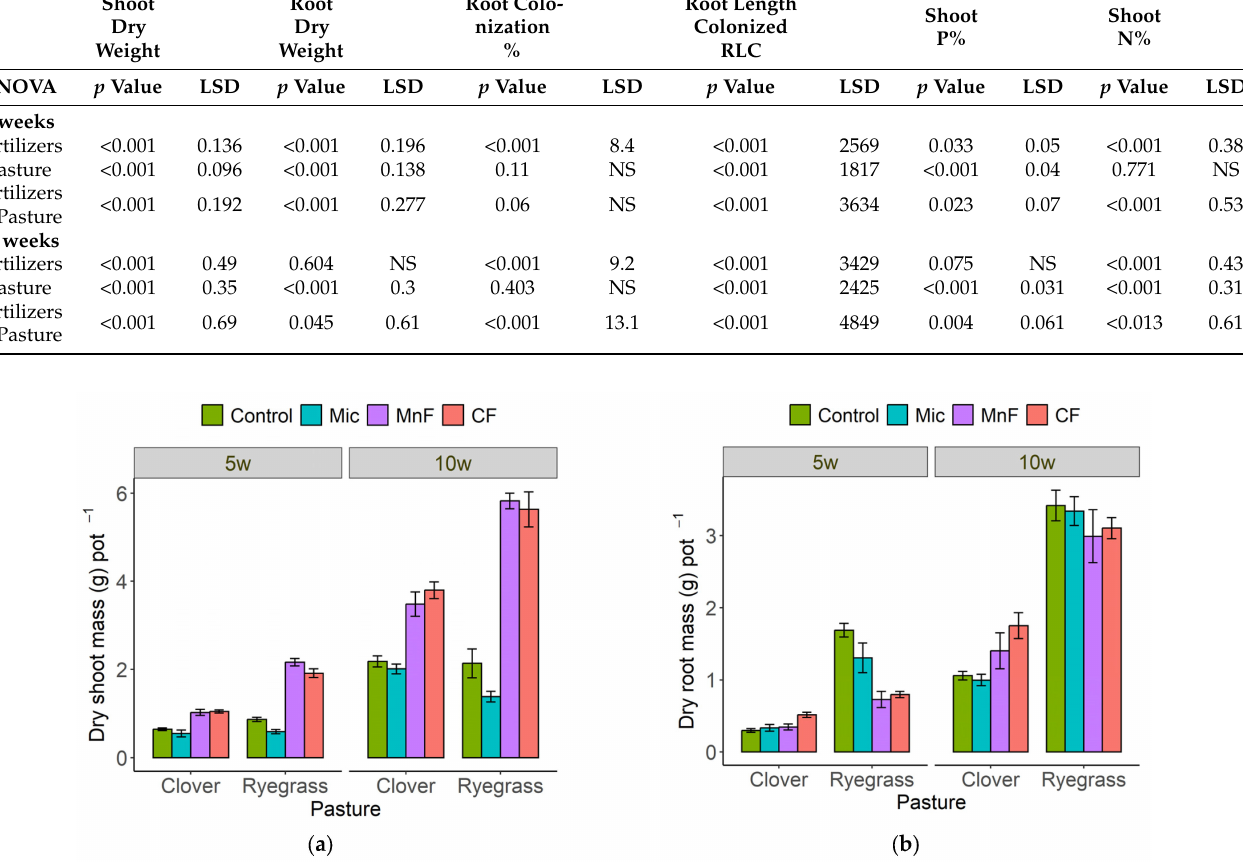
Figure 1. Shoot ( a ) and root ( b ) dry mass (g pot − 1 ) for subterranean clover and annual ryegrass grown separately at 5 and 10 weeks. Treatments were untreated soil (control), rock mineral fertilizer (MF), chemical fertilizer (CF) and microbial inoculant (Mic). Data for 10 week harvest previously reported by Mickan et al. [18]. Results are presented as means + standard